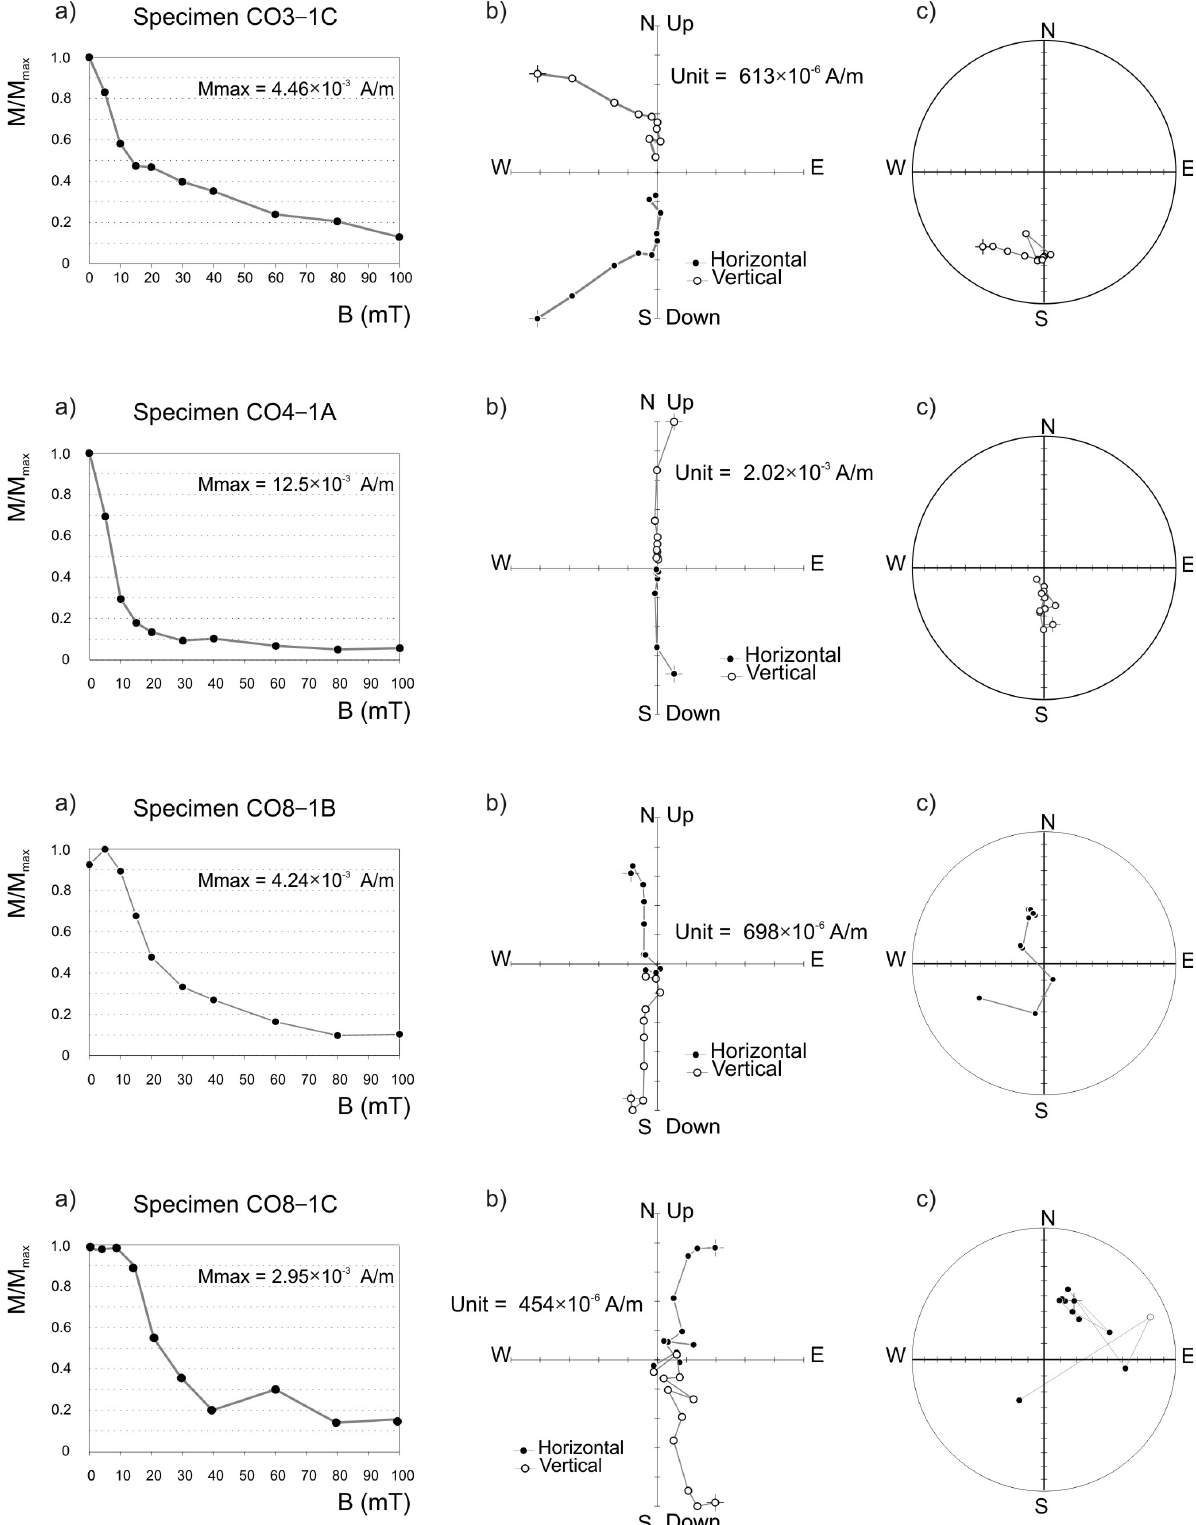
Figure 4. Examples of the magnetization behavior of reversed (first two rows) and normally polarized (last two rows) specimens during Alternating Field (AF) cleaning. For each specimen: ( a ) the decay of the normalized magnetization intensity versus the applied field; ( b ) the Zijderveld diagrams (black/white dots are declination/apparent inclination, respectively); and ( c ) equal-area projection of magnetic direction (black/white dots are positive/negative inclination, respectively).